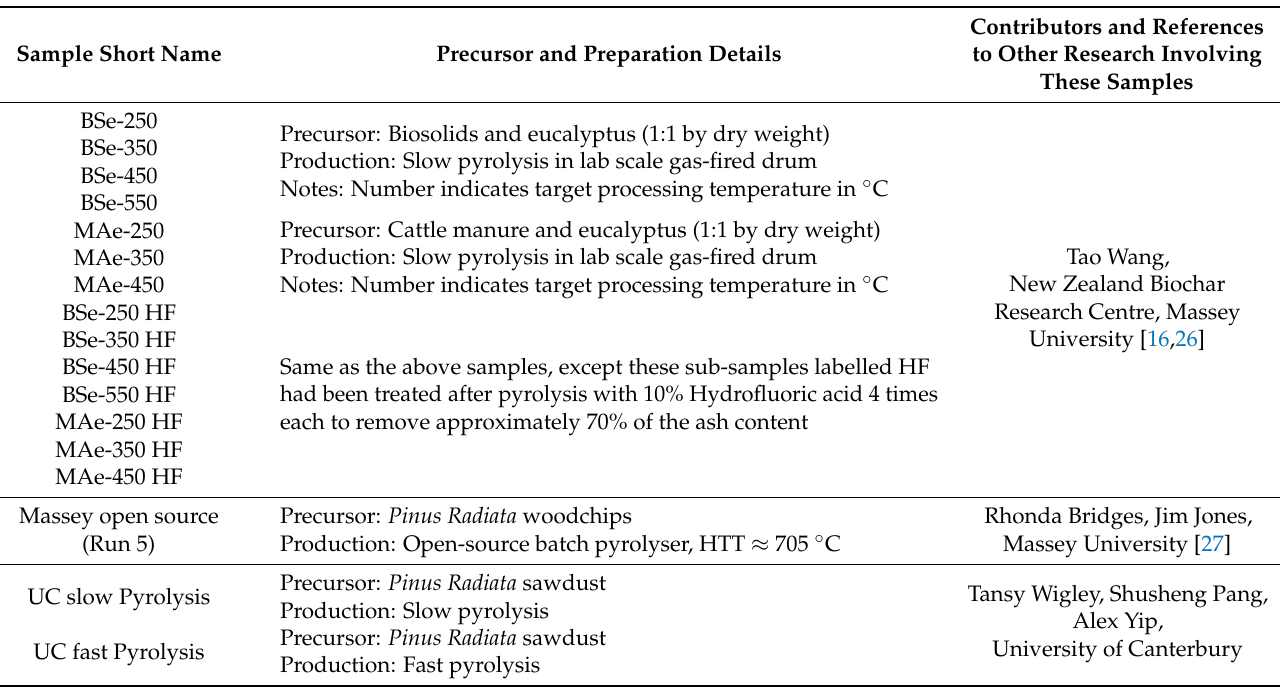
Table 1. Sample details provided by contributors and references were chars feature in other